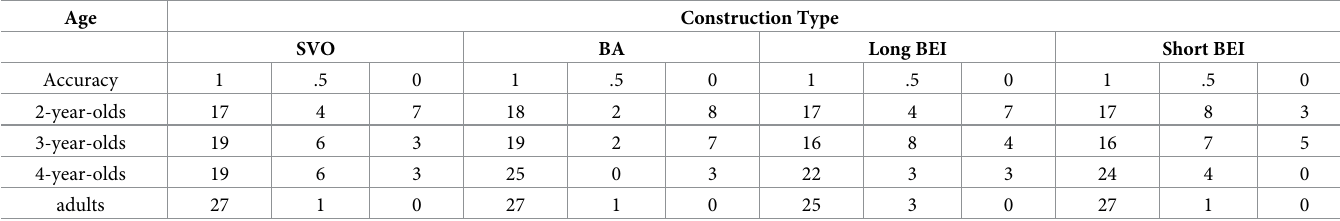
Table 5. The number of participants who responded correctly for each construction type across ages.